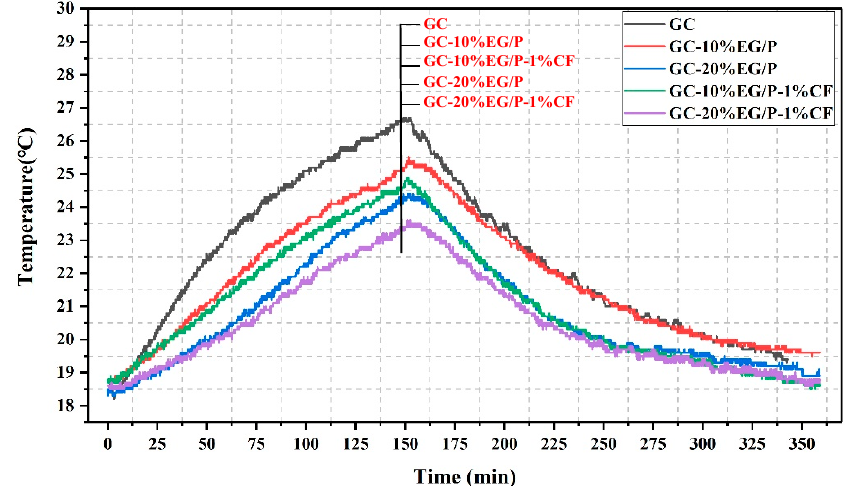
Figure 9. Temperature curves of center point of five small house models.